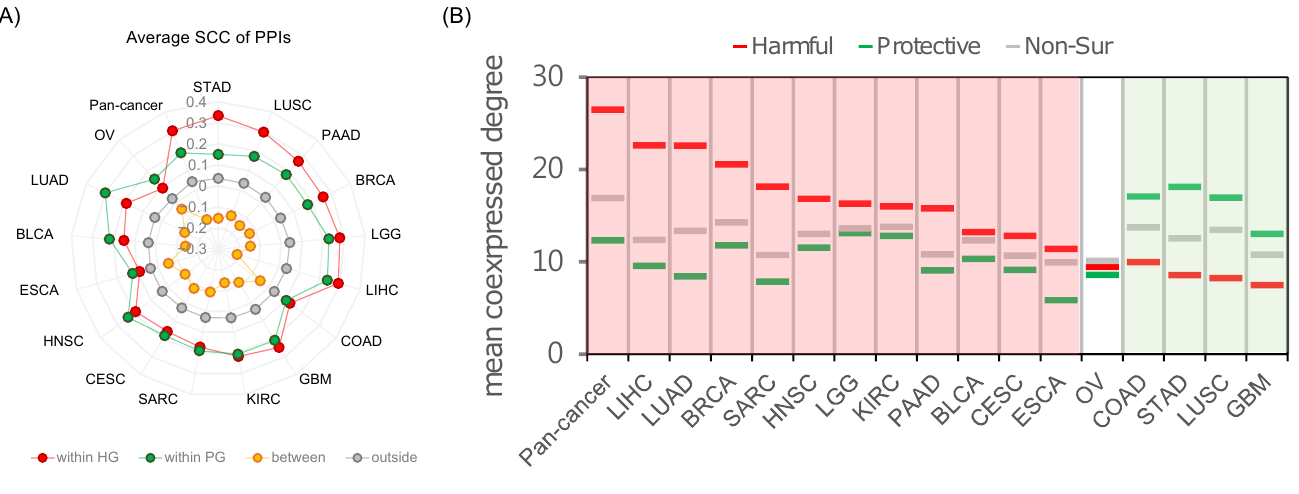
Figure 3. Co-expressed protein-protein interaction among SIGs. ( A ) The average Spearman correlation coefficient (SCC) between SIGs in cancers. The average SCCs were calculated between two genes forming PPI only. The red and green circles represent the mean SCCs within harmful and protective SIGs, respectively; yellow circles are the mean SCCs between harmful and protective genes, between SIGs with different types; grey circles are SCCs between non-SIGs. ( B ) Comparison of the co-expressed degree between harmful and protective SIGs and non-SIGs. The co-expressed degree is the number of significantly co-expressed (z-score of SCC ≥ 2) PPI partners of one